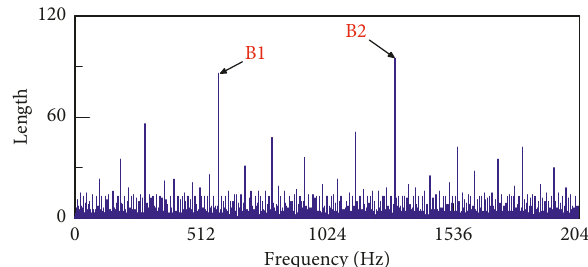
Figure 6: The OSSP obtained by the OSSR approach.